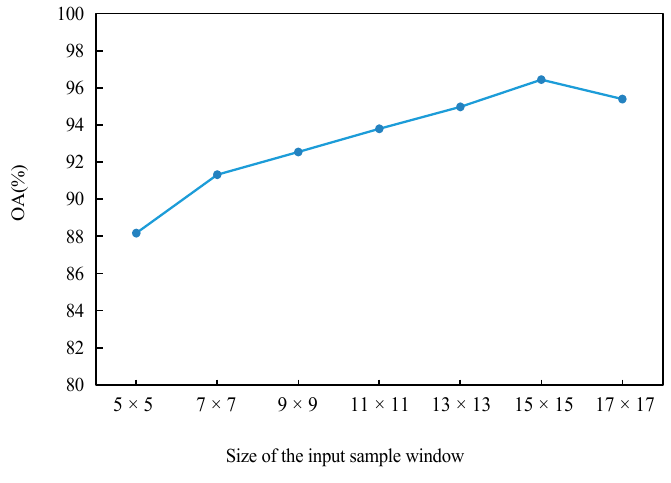
Figure 9. Size of the input sample window and OA.